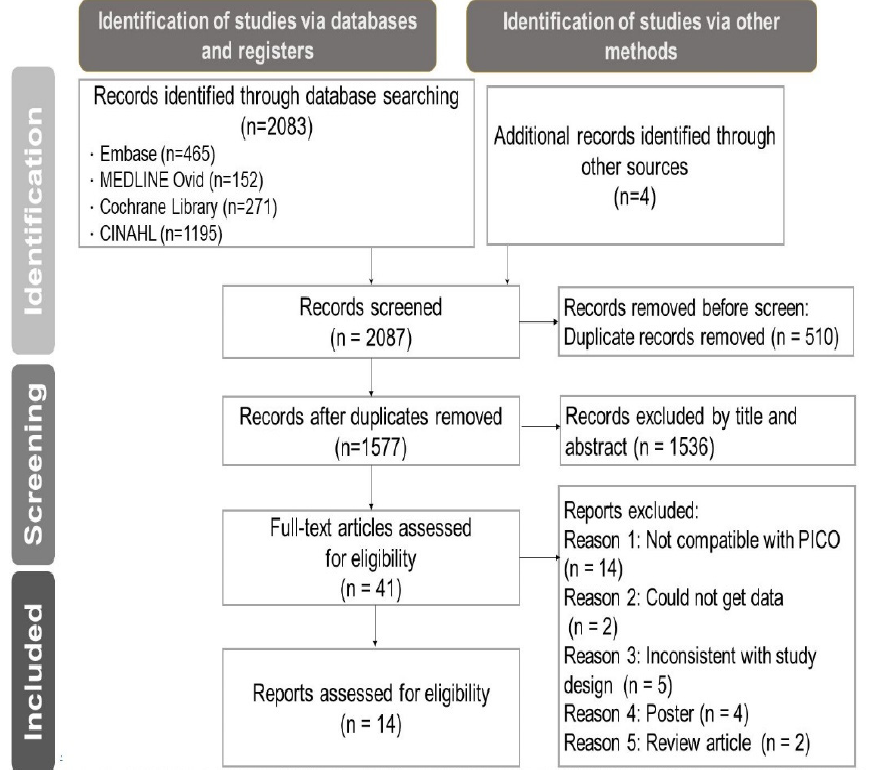
Figure 1. PRISMA flow diagram of study selection.